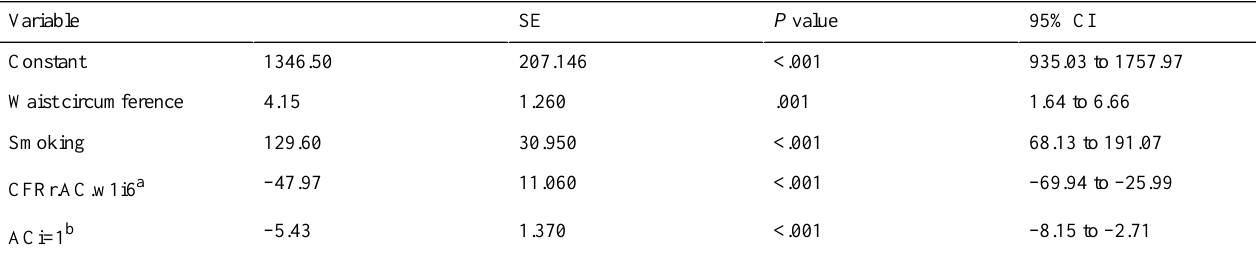
Table 2. Physical predictors of 3000-meter running qualification (univariate).